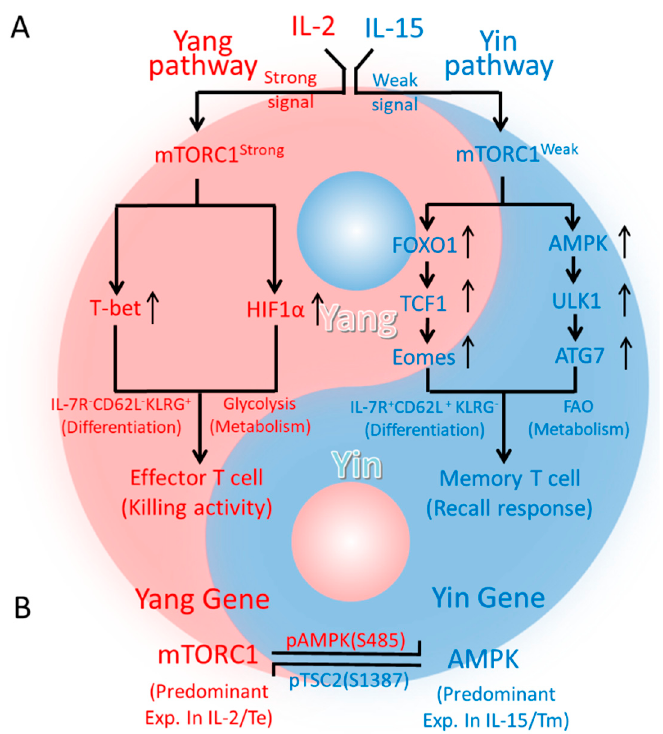
Figure 6. Schematic diagram of the interplay between Yin (AMPK1 α ) and Yang (mTORC1) energy sensors in T-cell differentiation. ( A ) IL-2 stimulates an mTORC1 Strong or Yang signal, leading to proliferative T E -cell formation via activation of the transcriptional T-bet (Yang) and the metabolic HIF-1 α (Yang) pathways. In contrast, IL-15 induces an mTORC1 Weak or Yin signal leading to quiescent T M cell formation via activation of the transcriptional FOXO1-TCF1-Eomes (Yin) and the metabolic AMPK-ULK1-ATG7 (Yin) pathways. ( B ) The graph shows the negative interplay between Yin (AMPK1 α ) and Yang (mTORC1) genes. In this figure, red represents Yang gene mTORC1 controlling T E -cell growth, differentiation and glycolytic fuel preference for energy production, while blue represents Yin gene AMPK1 α regulating T M -cell quiescence and survival by using FAO for energy